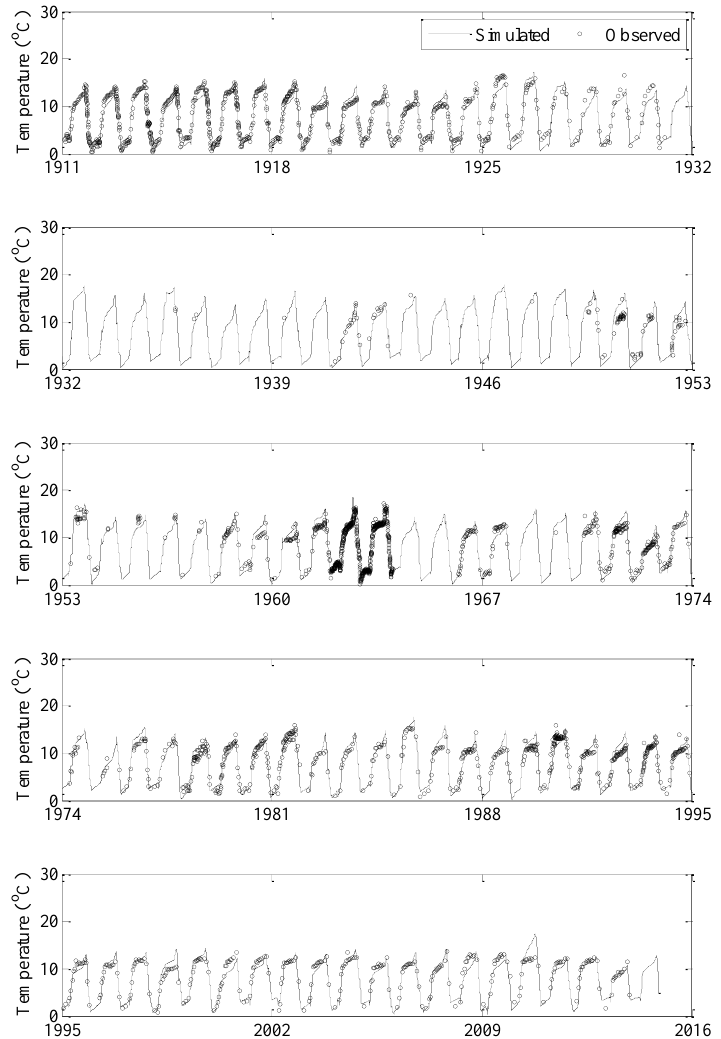
Figure 6. Time series of the simulated and observed volume-weighted near-bottom (hypolimnetic) temperatures (20–25m) from 1911–2014.